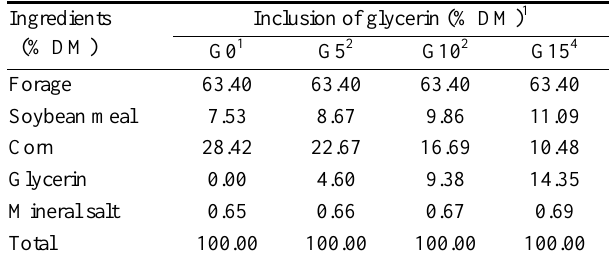
Table 1. Ingredient composition of the total diet Ingredients